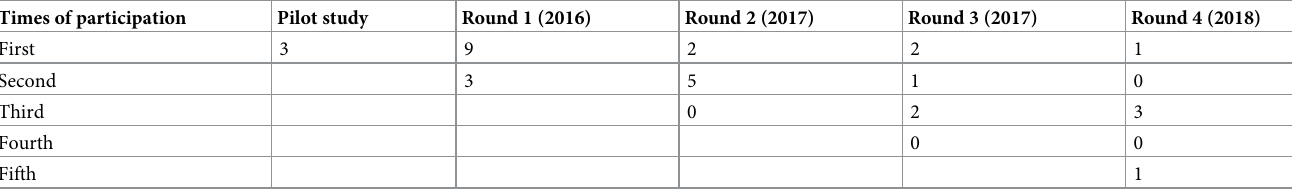
Table 4. Laboratories scoring unsatisfactorily and their times of participation into the PT scheme. Times of